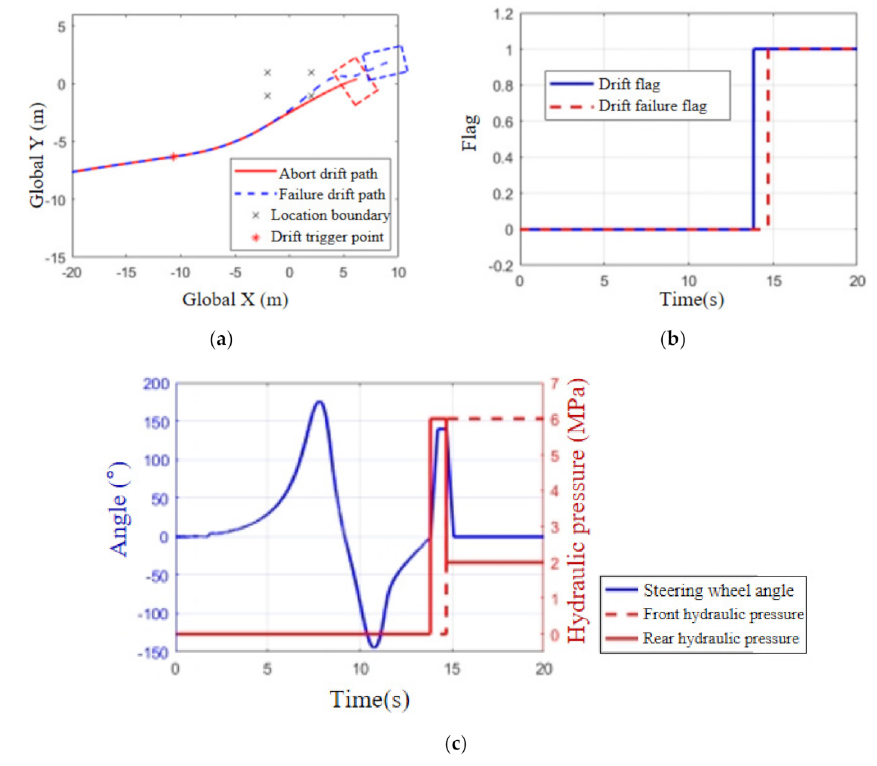
Figure 7. Simulation test of drift process failure monitoring strategy: ( a ) Vehicle path; ( b ) Drift flag; and ( c ) Actuator